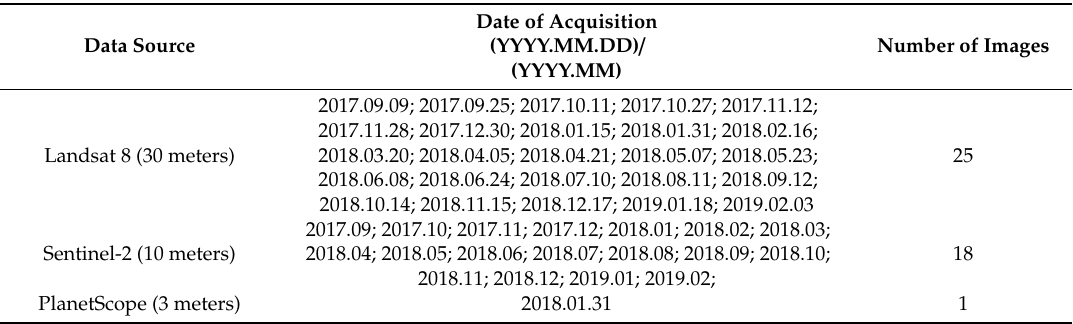
Table 1. List of satellite data products used in this study and their date of acquisition. Sentinel-2 data includes monthly median values of the